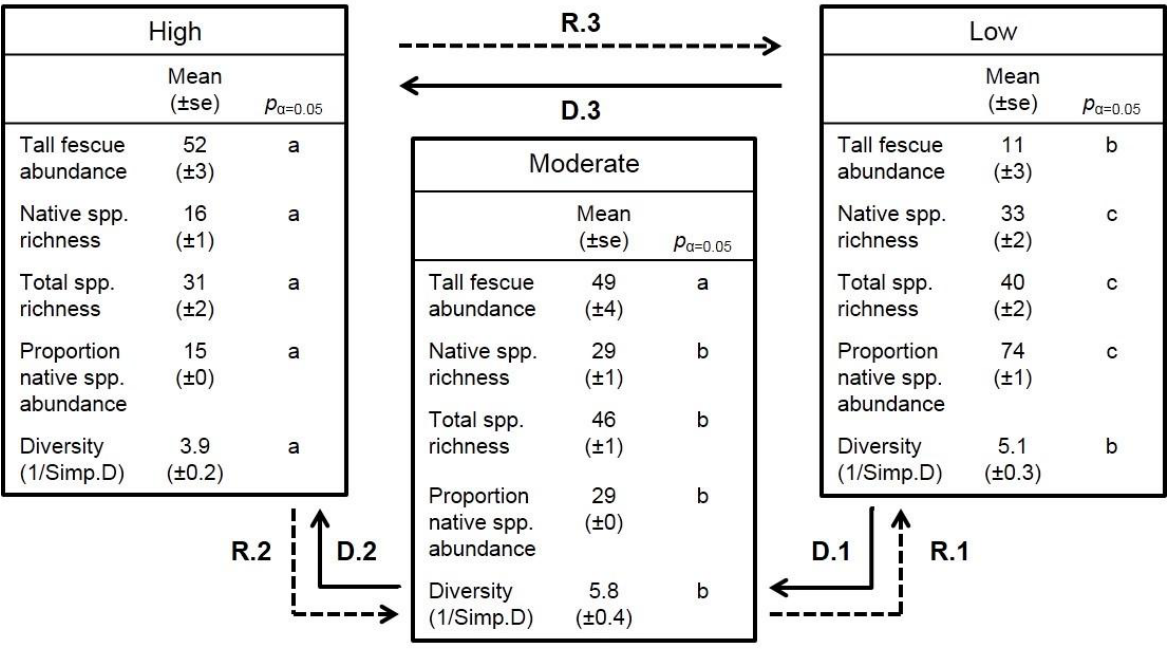
Figure 6. Summary of plant community data for three vegetation degradation states identified by hierarchical cluster analysis of 196 plant species abundance sampled from nine tracts in the Grand River Grasslands of south-central Iowa and north-central Missouri, USA. States (boxes) describe distinct plant communities with similar compositional attributes, and letters give results of pair-wise t-tests ( p ) comparing each attribute α = 0.05 across degradation states; different letters indicate significance at p < 0.05. Characteristic species for each state are given in Table 1. States are linked by hypothetical degradation (D) and restoration (R) pathways to create a simple state-and-transition model [32]. See Discussion for full description of transition